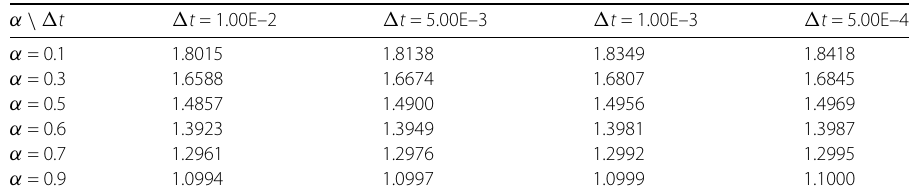
Table 5 Temporal convergence orders of w for Example 4.2